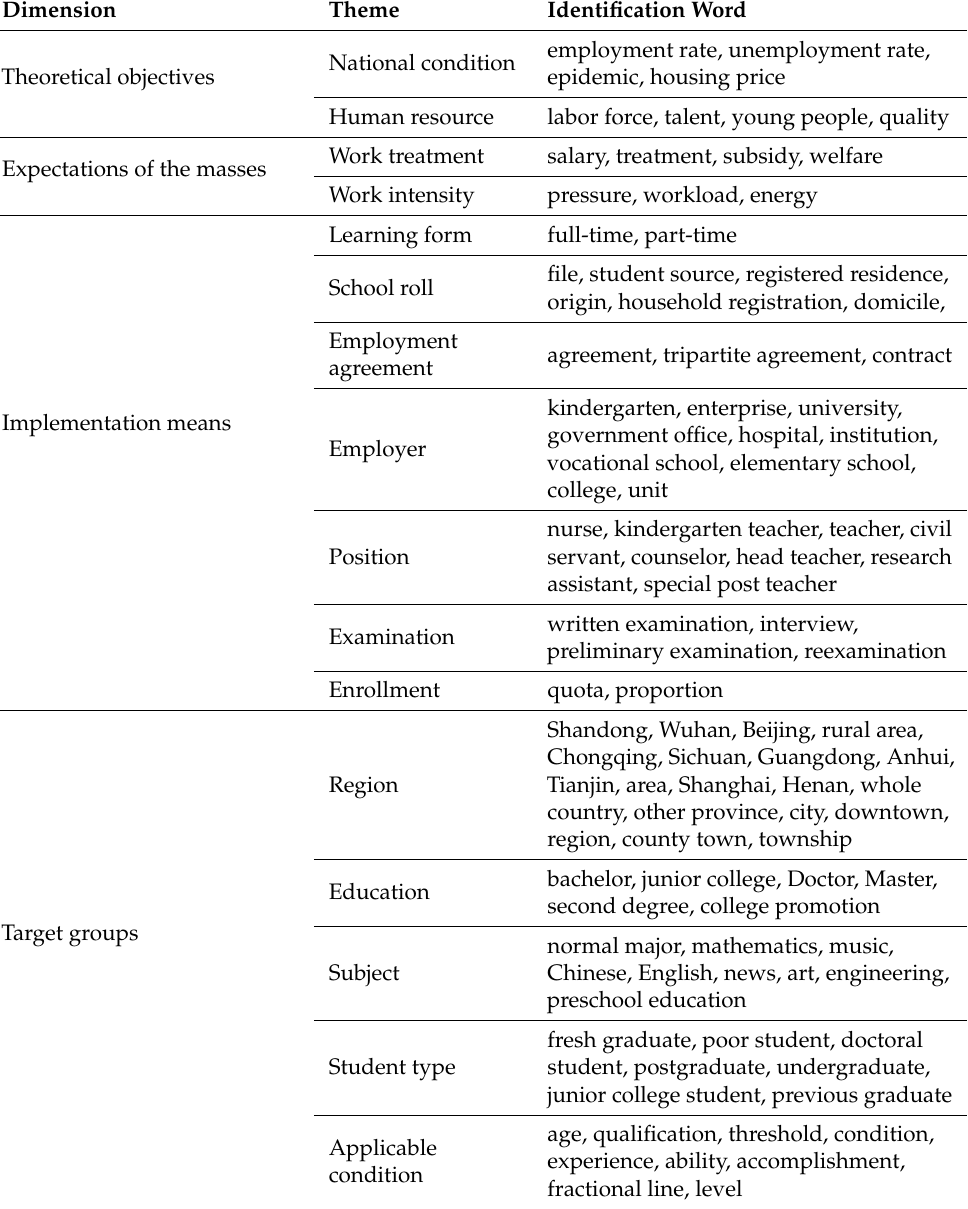
Table 8. Comment topic identification